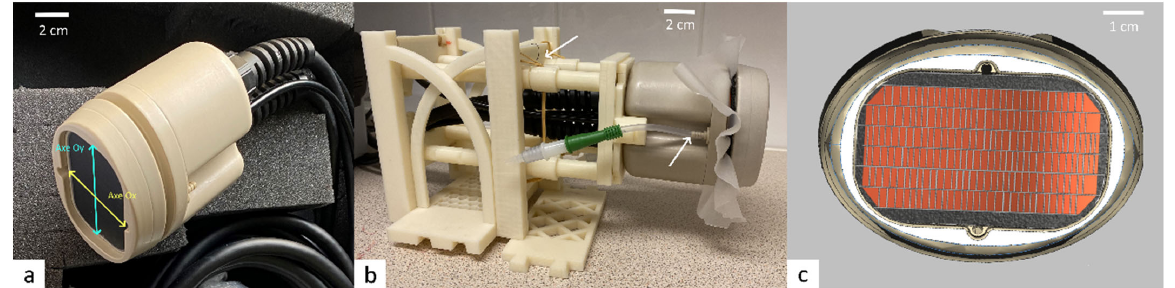
Figure 3. The novel hyperthermia transducer for prostate cancer. ( a ) Transperineal phased array transducer; ( b ) customized 3D printed holder and water circuit (white arrows); ( c ) padding of the active surface with acoustic elements.